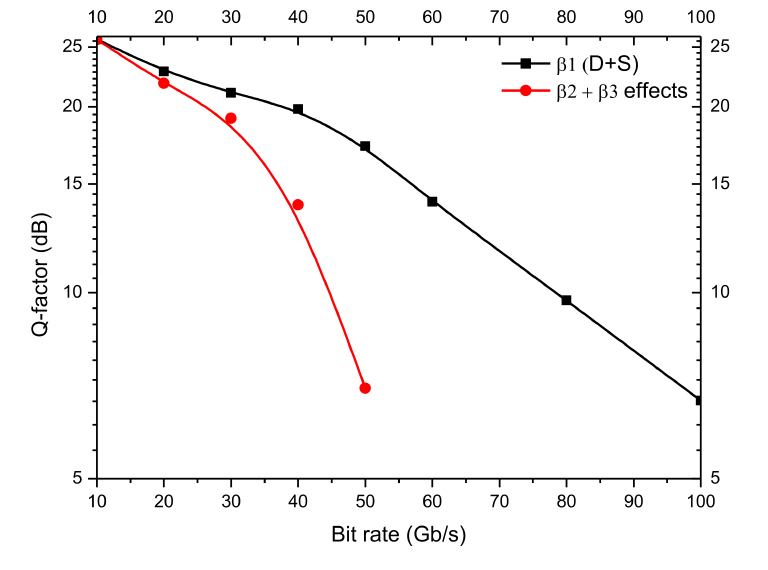
Figure 3. SAC-OCDMA system performance versus bit